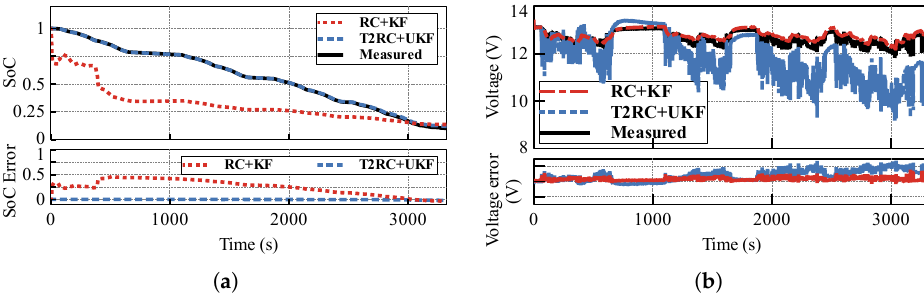
Figure 13. Method performance validation using robot operation data for the LFP battery pack: ( a ) SoC estimation performance of the RC model with KF (RC+KF) and the 2 RC Thevenin model with UKF (T2RC+UKF). ( b ) Comparison of battery voltage estimation performance of RC model with KF (RC+KF) and the 2 RC Thevenin model with UKF